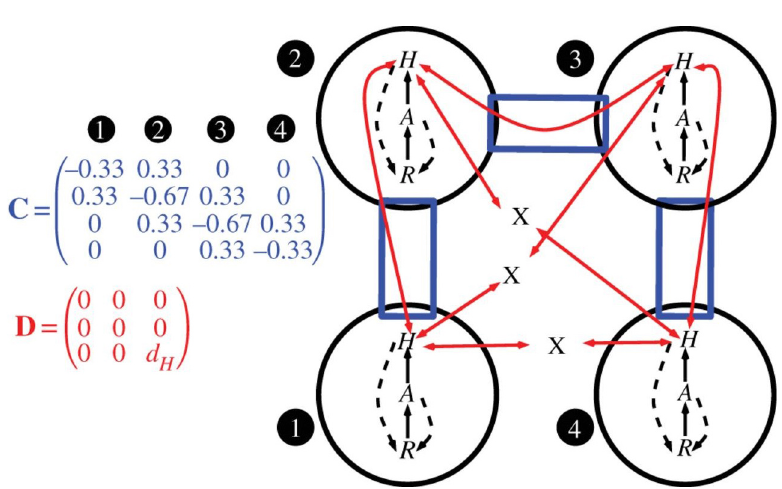
Figure 2. From metacommunities to meta-ecosystems: cycling of matter across spatial networks of interaction networks. Conceptual diagram for a general meta-ecosystem model that can predict the role of interaction strength between species and between locations for the exchange of individuals and matter. Local ecosystems (circles) have internal dynamics based on trophic (solid arrows) and non- trophic (dashed arrows) interactions between ecosystem compartments, which in this case are a limiting nutrient (R), autotrophs (A) and herbivores (H). Local ecosystems form a meta-ecosystem through the movement of materials and organisms, which is determined by the connectivity matrix C and the movement matrix D. The connectivity matrix indicates how the ecosystems are connected to one another (rectangular boxes), whereas the movement matrix gives the movement rates of each ecosystem compartment (two-headed arrows). Without a connection specified by the connectivity matrix, materials and organisms cannot move between ecosystems (capital X). Reprinted with permission from Elsevier 64